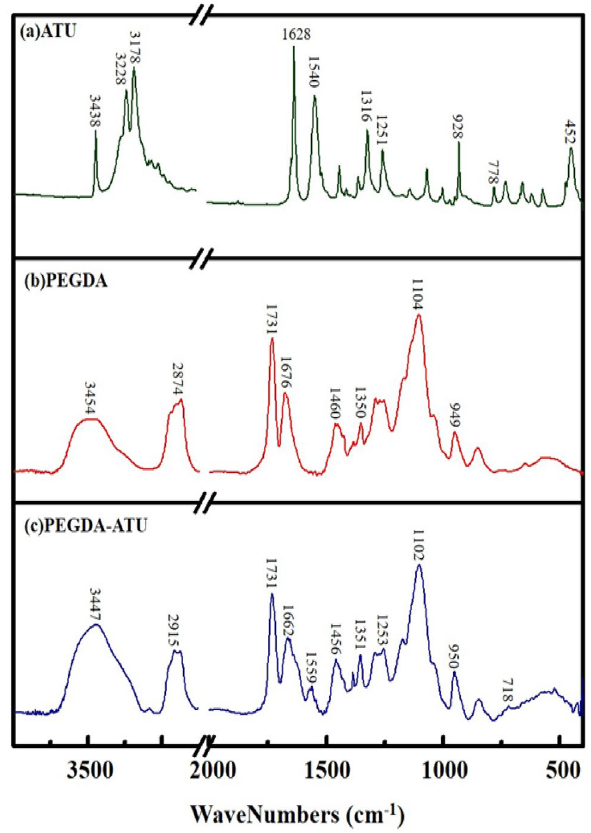
Figure 1. FT-IR spectra of ( a ) ATU; ( b ) PEGDA; and ( c )